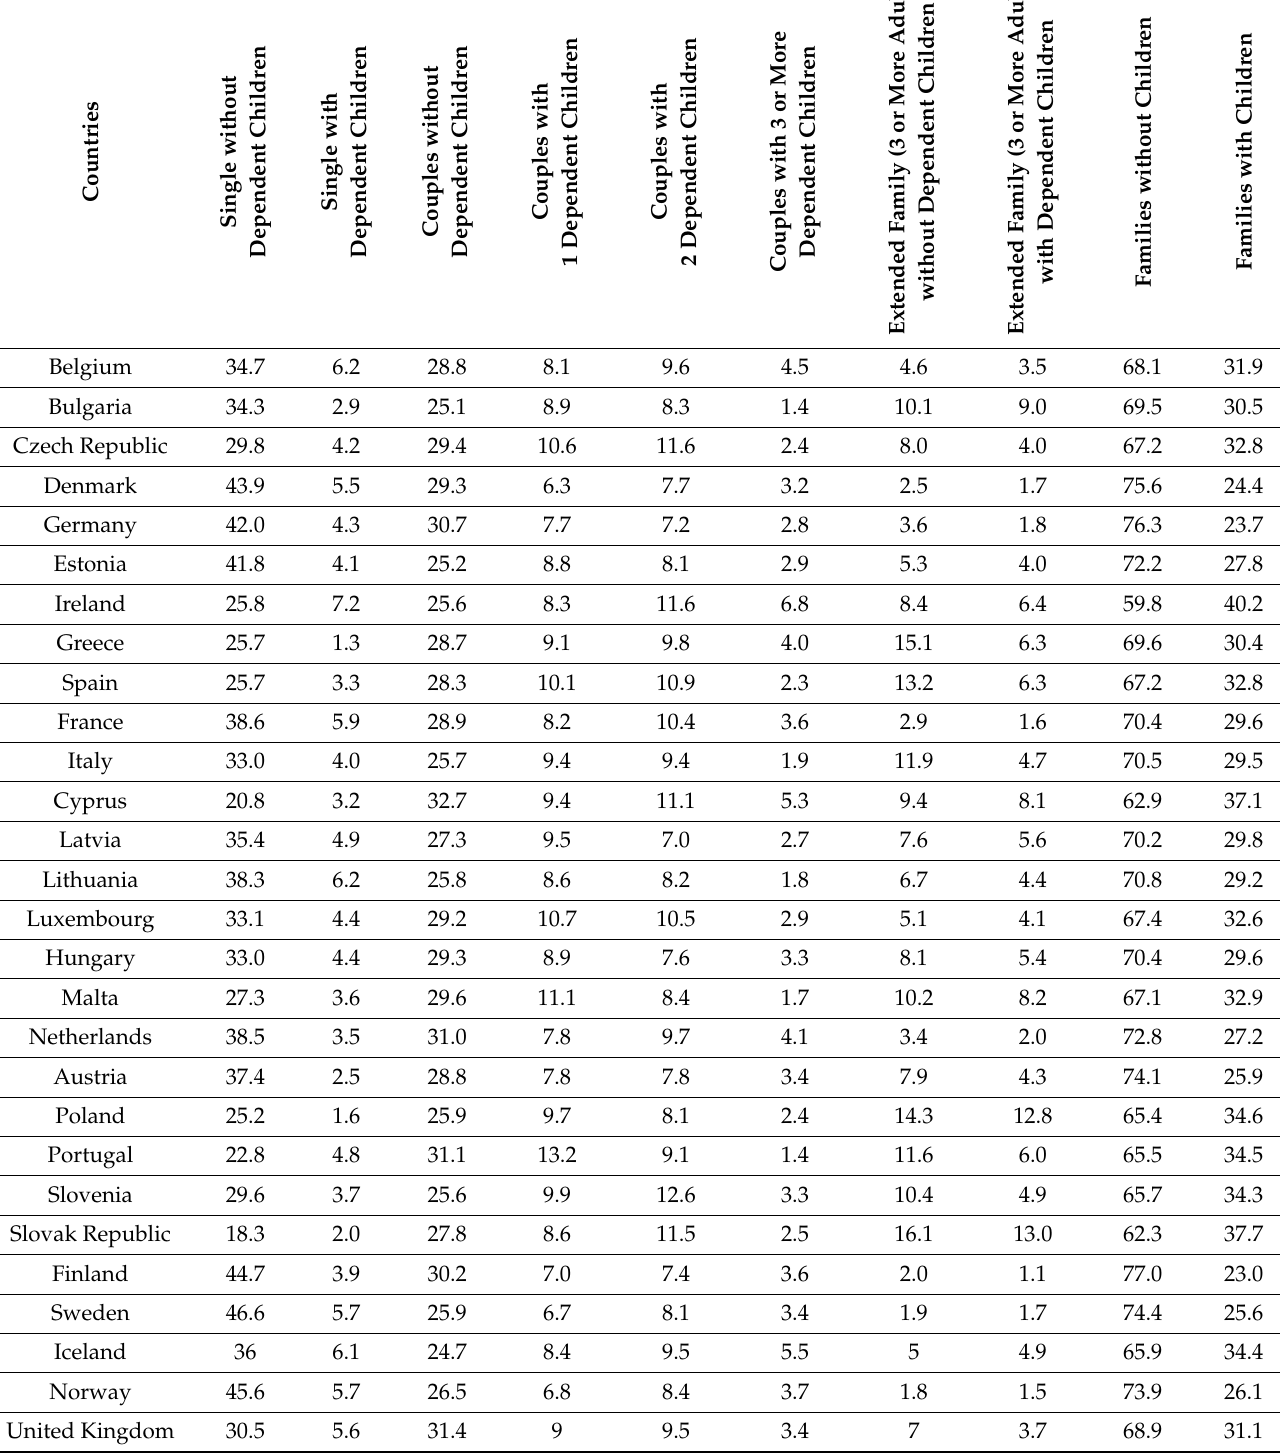
Table A2. Family composition in the countries under investigation